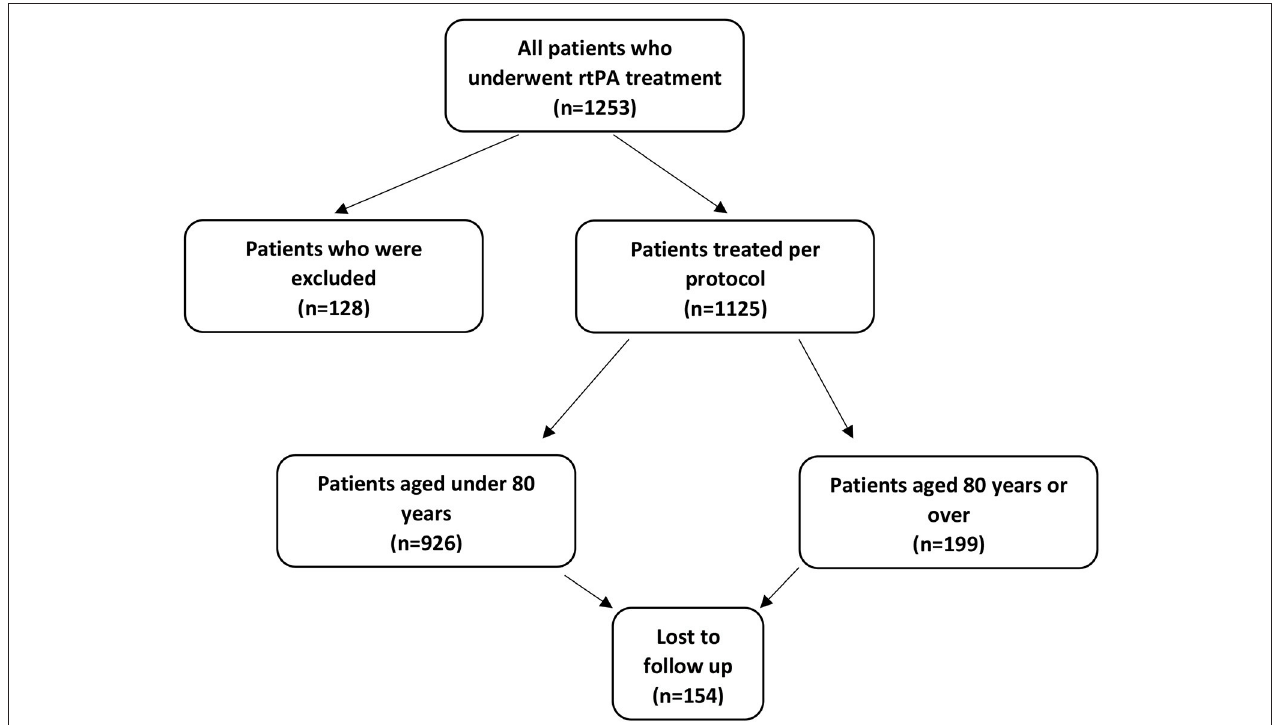
FIGURE 1 | Flow chart of participants (rtPA: recombinant tissue plasminogen